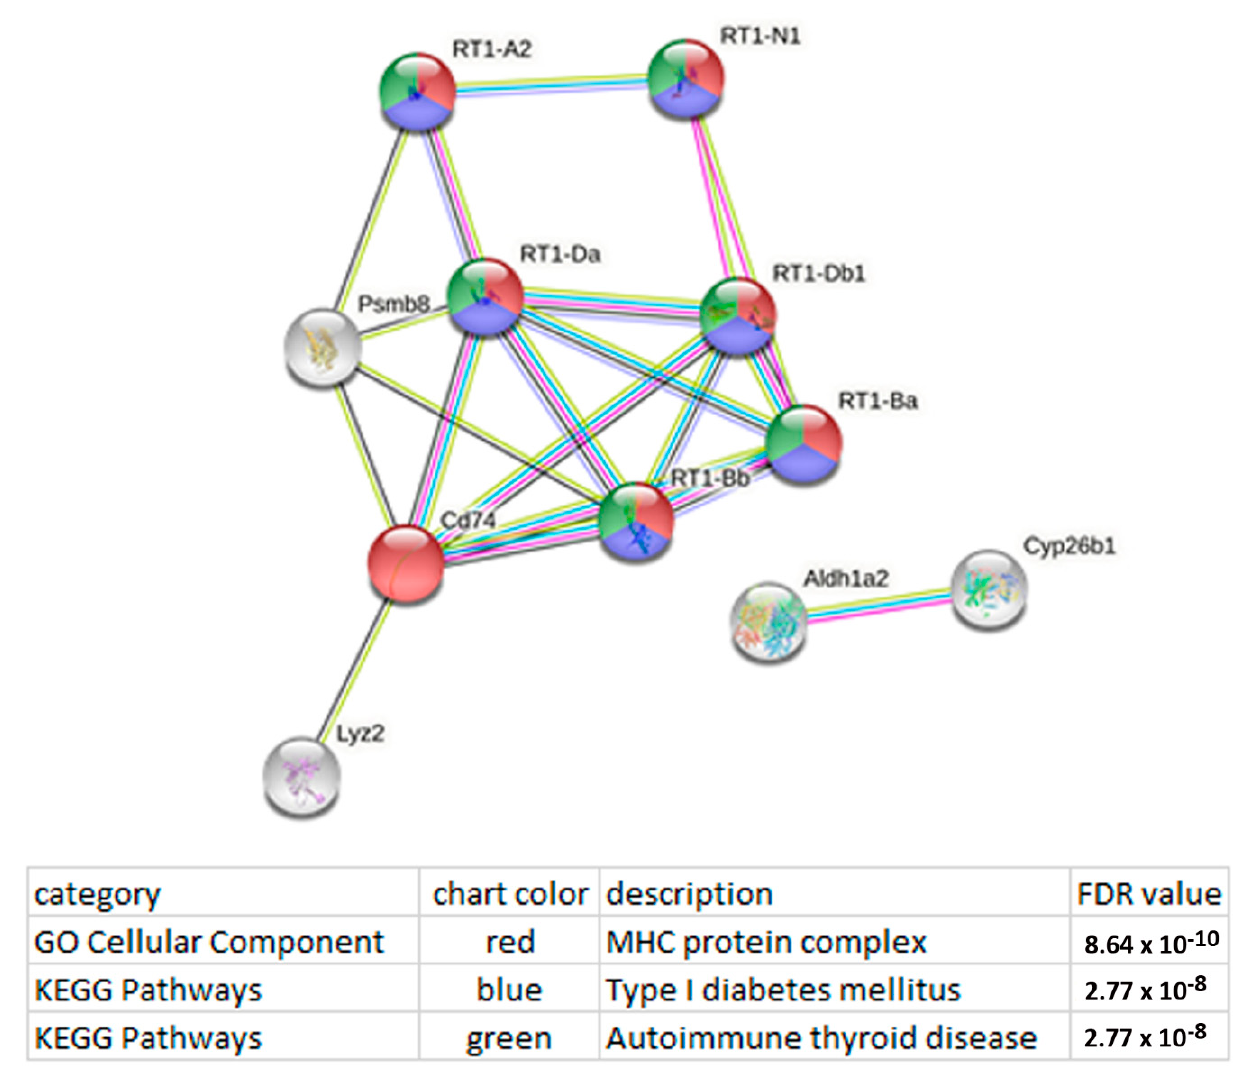
Figure 7. Functional enrichment analysis of the lncRNA RGD1562890 network points to possible participation of this lncRNA in both antigen processing and presentation and type 1 diabetes mellitus. The functional enrichment network was constructed by means of the STRING database [22] using the DEGs whose expression correlated with the expression of lncRNA RGD1562890. Each node represents all the proteins produced by a single protein-coding gene. The key links associated with antigen processing and presentation and type 1 diabetes mellitus are Cd74 (CD74 molecule); Lyz2 (lysozyme 2); Psmb8 (proteasome 20 S subunit beta 8); RT1-A2 (RT1 class Ia, locus A2); RT1-Ba (RT1 class II, locus Ba); RT1-Bb (RT1 class II, locus Bb); RT1-Da (RT1 class II, locus Da); RT1-Db1 (RT1 class II, locus Db1); RT1-N2 (RT1 class Ib, locus N2). Edges represent protein–protein associations. Purple lines indicate experimentally determined interactions; blue lines denote known interactions from curated databases; dark blue lines represent gene co-occurrence; black lines indicate coexpression; green lines represent results of text mining. Protein–protein interaction (PPI) enrichment p -value: 1.11 × 10 − 15 .